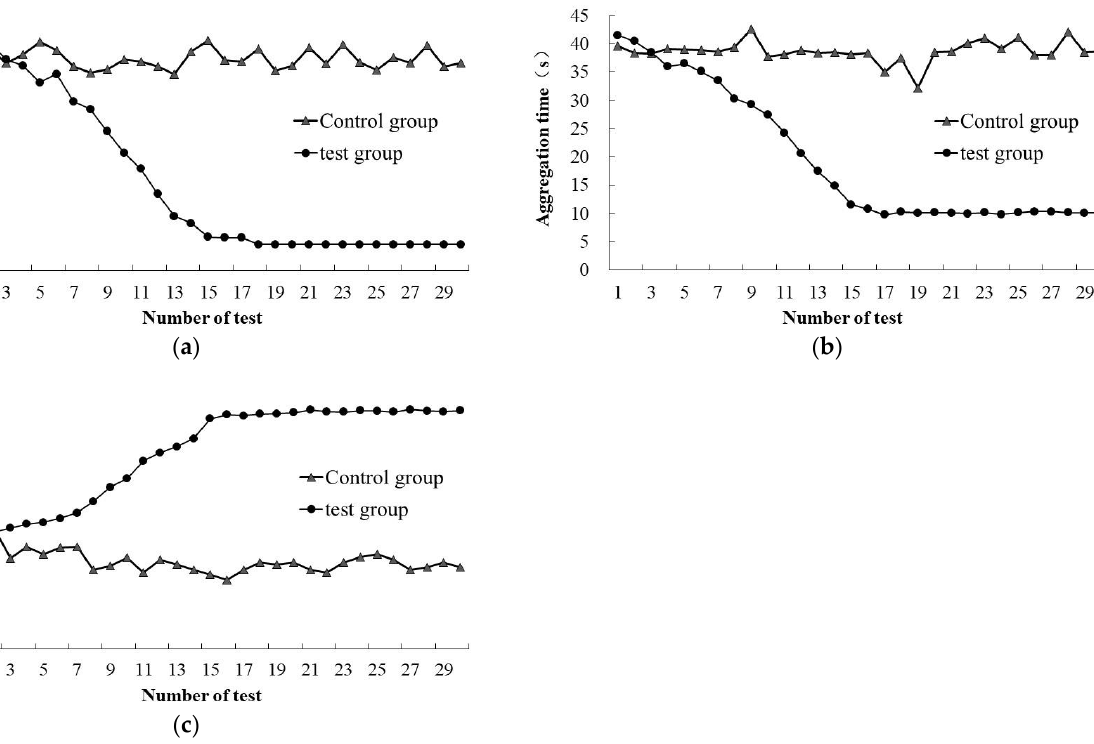
Figure 12. Changes in the response time ( a ), aggregation time ( b ), and aggregation rate ( c ) of juvenile Pagrus major with the elimination of conditioned reflex test.